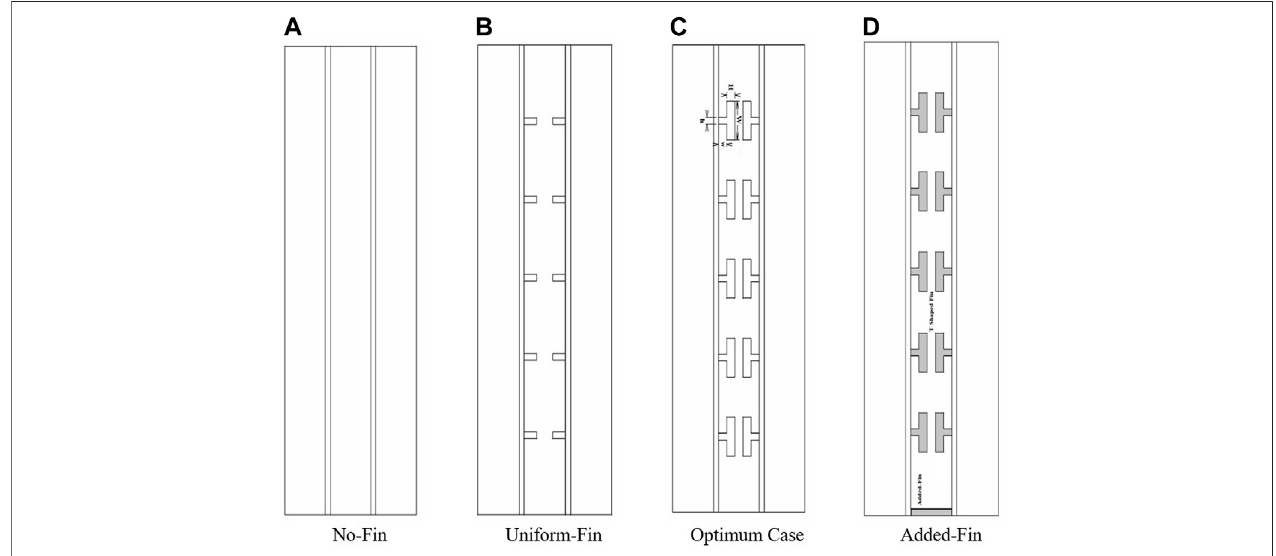
FIGURE 1 | A schematic of the proposed systems under axisymmetric conditions. (A) No-Fin, (B) Uniform-Fin, (C) Optimum Case, (D) Added-Fin.